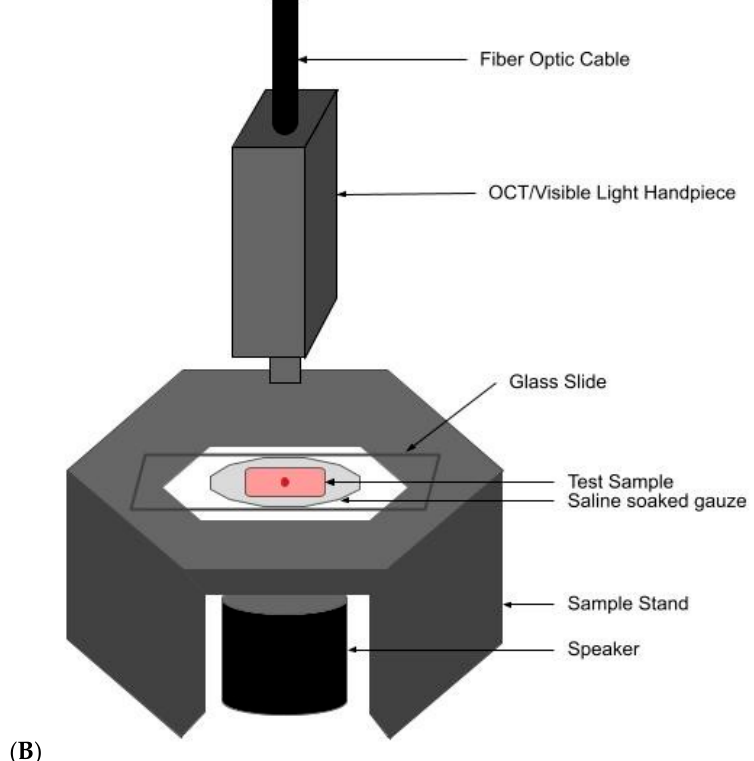
Figure 1. ( A ) Block diagram of the setup of an OCT device modified to do vibrational optical coherence tomography (VOCT). The speaker shown, which is 2 inches in diameter, provides audible sound through a computer-driven app to vibrate the sample between 30 and 300 Hz. The displacement of the sample at each frequency is obtained from amplitude data collected and stored from raw images created by the OCT. ( B ) Schematic drawing of the specimen holder and the OCT handpiece used to collect the VOCT data at each frequency on skin lesion biopsies. The biopsy sample is placed on saline-wetted gauze to prevent dehydration during testing.